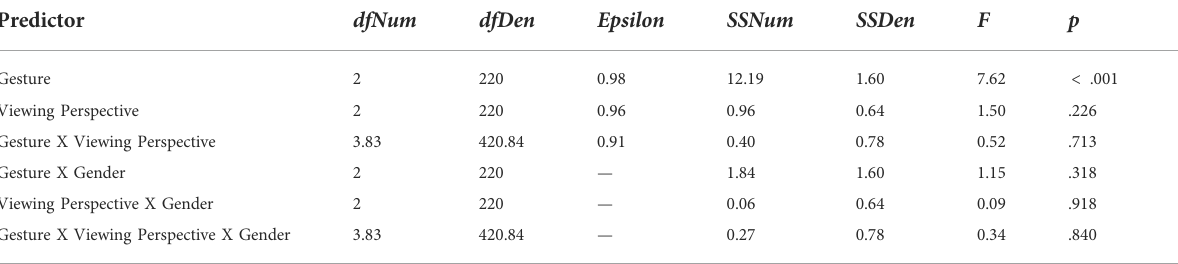
TABLE 8 Results of the mixed-measures ANOVA for the perceived threat of the robot. Predictor Gesture